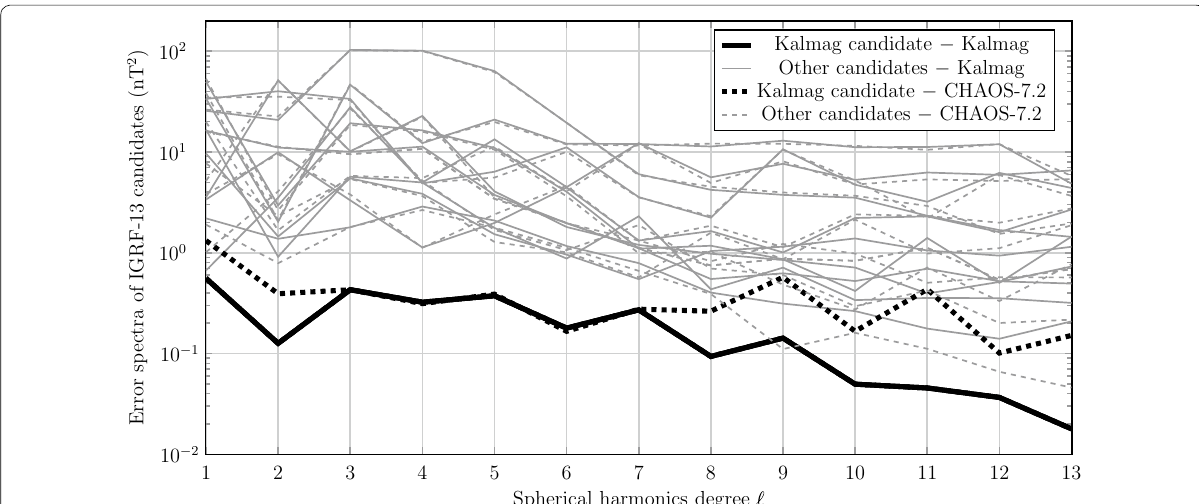
Fig. 5 Energy spectra at the Earth’s surface of the difference between every IGRF-13 candidate model, and the latest version of the Kalmag model (continuous lines) as well as the CHAOS-7.2 model of Finlay et al. (2020) (dashed lines) in 2020.0. The spectra associated with the Kalmag candidate are highlighted by thick black